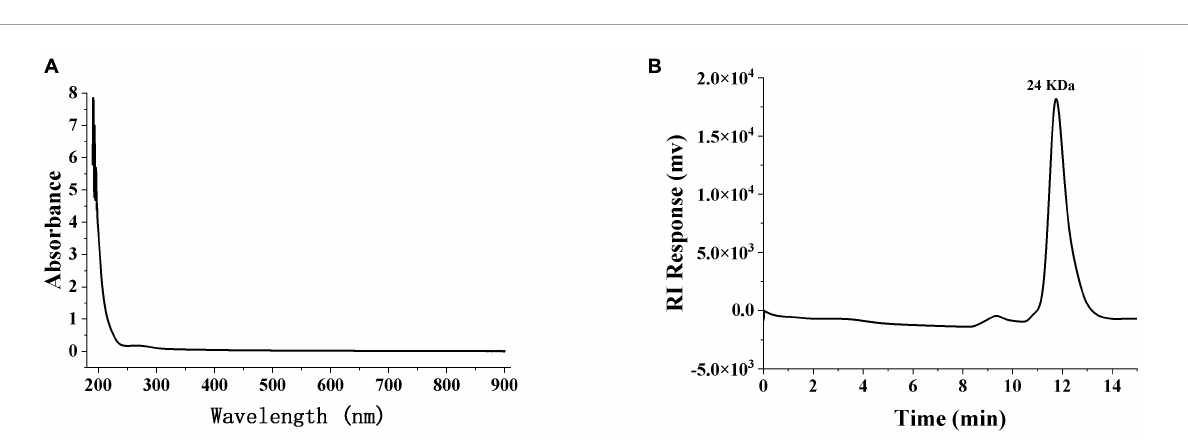
FIGURE3 The ultraviolet spectroscopy (A) and HPGPC (B) of SRF-3. SPF-3 was configured as a 1 mg/ml solution, samples were scanned in a quartz colorimetric cup at 190–900 nm for UV-vis full wavelength, and zeroed with distilled water as a